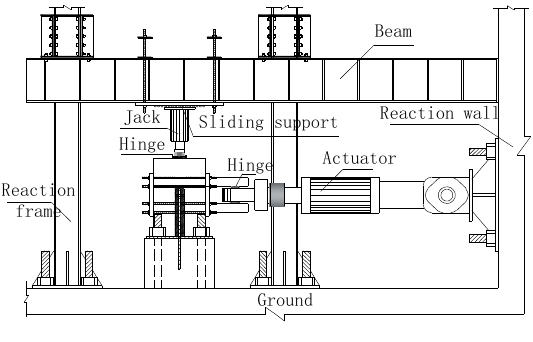
Figure 4. Loading device.